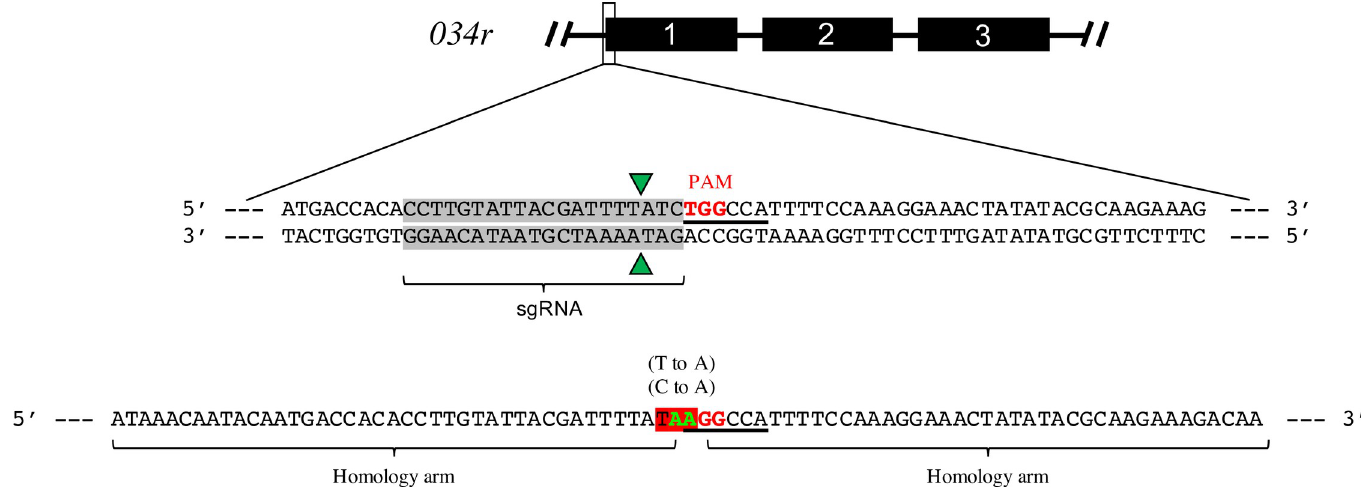
Fig 4. sgRNA and ssODN designs for targeting CA-4B glycosyltransferase-gene 034r . Top: Cartoon rendering of CA-4B glycosyltransferase-gene 034r composed of three domains. Middle: DNA sequence of the initial coding region of the 034r gene with the target site for Cas9/sgRNA binding, cleavage and editing highlighted in gray. Red TGG, PAM site; green triangles, Cas9 cleavage sites; underlined, MscI restriction site. Bottom: Design of ssODN to replace the dinucleotide, CT, with AA (green) in the target gene. The homology arms specific to the gene target are flanking the nucleotides designed to be changed (green font). Shaded red, newly created stop codon.